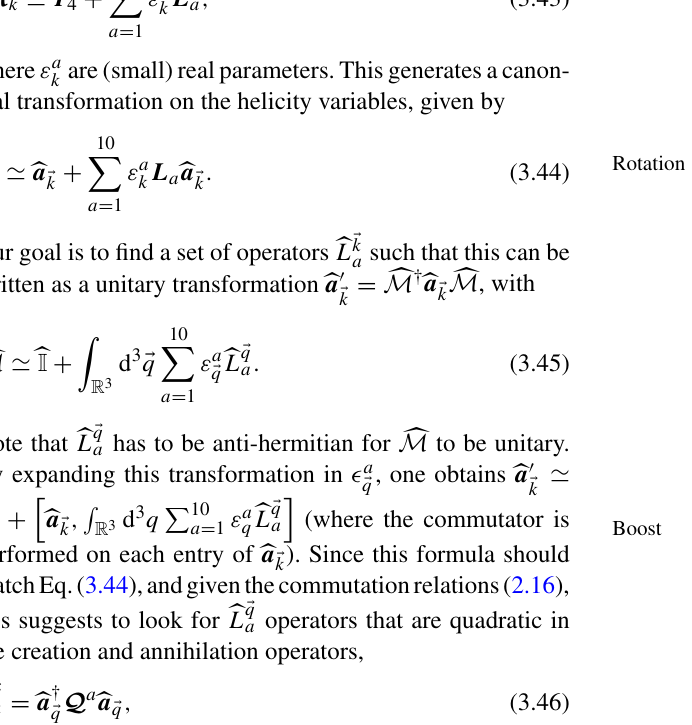
Table 3 Quantum representation of the generators of S p ( 4 , R )